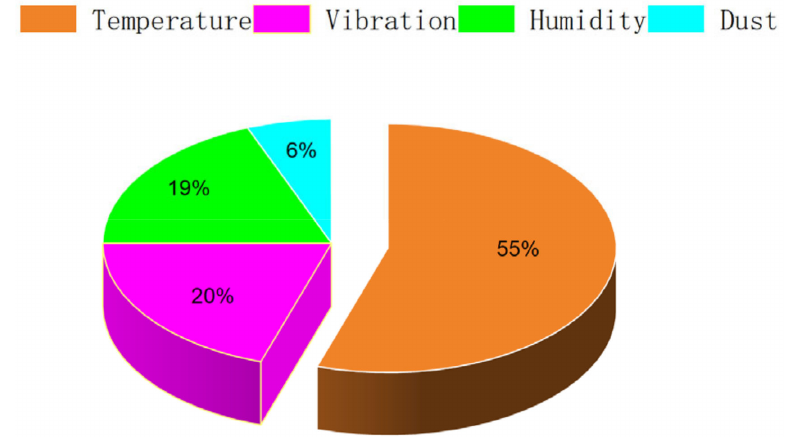
Figure 1. Factors affecting the failure of electronic components.